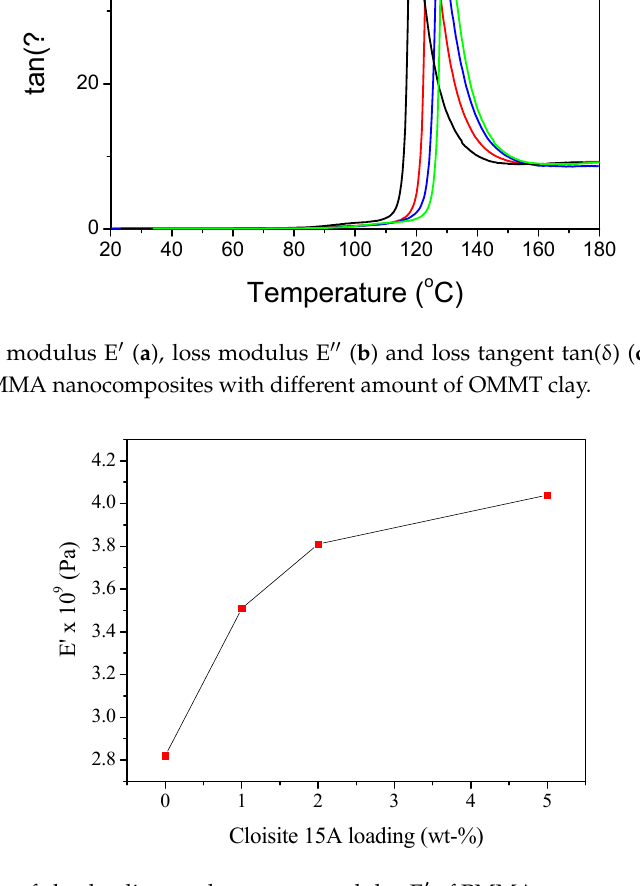
Figure 10. Effect of clay loading on the storage modulus E ′ of PMMA nanocomposites at 25 °C.